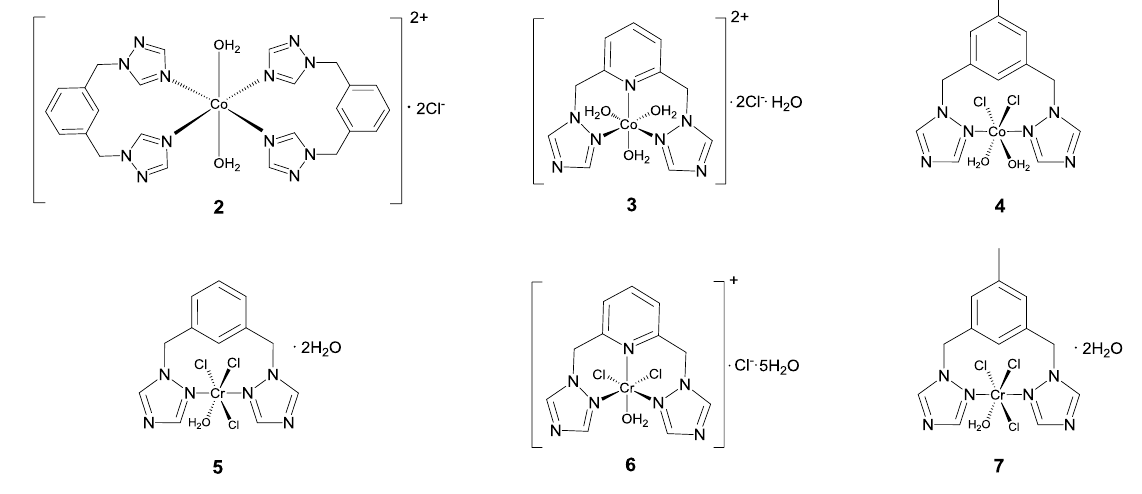
Figure 1. Possible structures of the complexes under study.